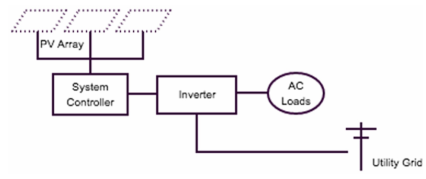
Figure 3. Grid-connected Photovoltaic